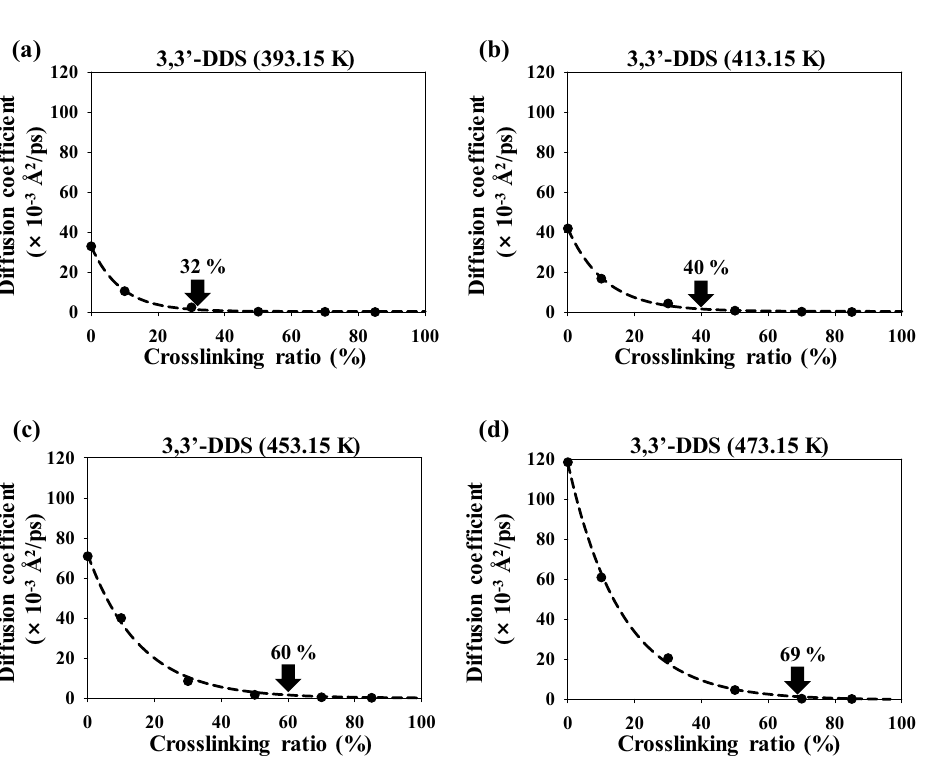
Figure 4. Diffusion coefficient of 3,3 ′ -DDS at ( a ) 393.15 K, ( b ) 413.15 K, ( c ) 453.15 K, and ( d ) 473.15